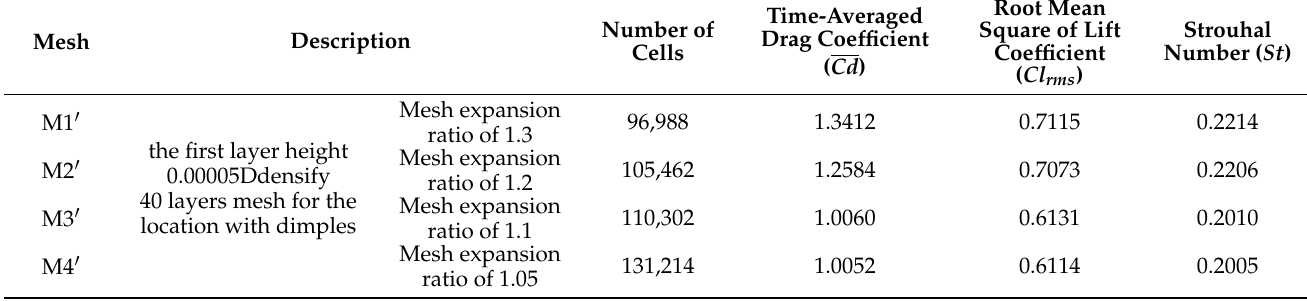
Table 3. Grid independence verification for the dimple cylinder at Re = 1 × 10 5 .